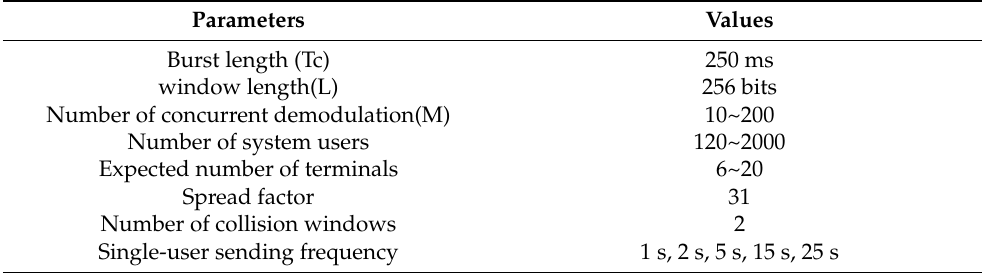
Table 3. Simulation parameters of R-SSA in the scenario of beam-hopping low-orbit satellite IoT. Parameters Values Burst length (Tc) 250 ms window length(L) 256 bits Number of concurrent demodulation(M) 10~200 Number of system users Expected number of terminals Spread factor